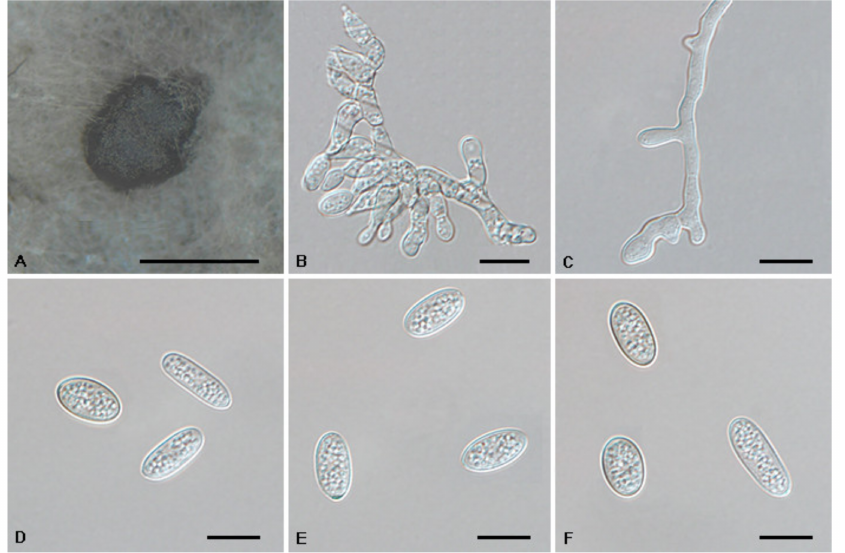
Figure 7. The morphology of Tubakia americana clade II (CFCC 56053). ( A ) Conidioma formed on PDA; ( B – C ) Conidiogenous cells giving rise to conidia; ( D – F ) Conidia. Scale bars: ( A ) = 300 µ m; ( B – F ) = 10 µ